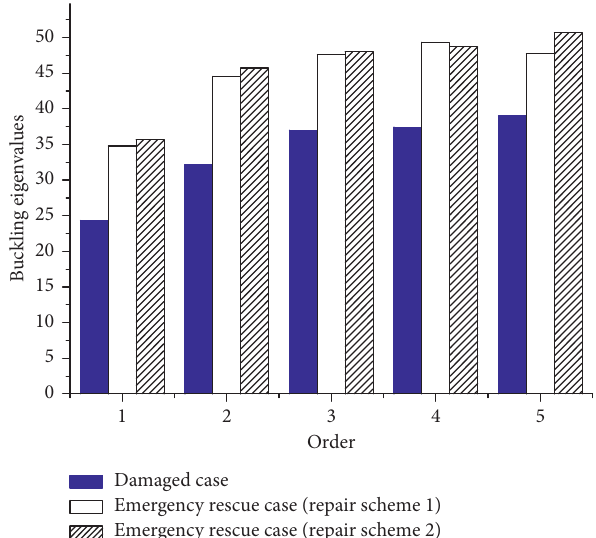
Figure 18: 1 st ∼ 5 th buckling eigenvalues calculated for different cases.